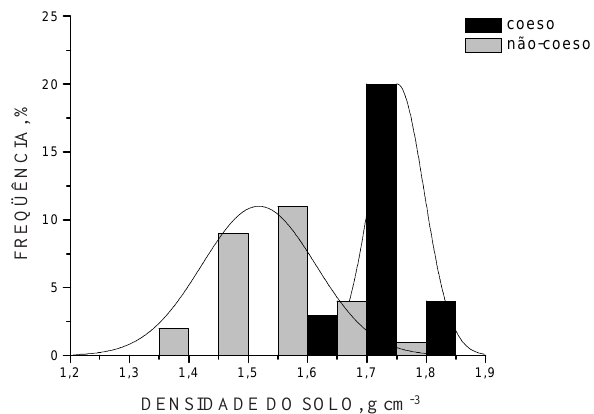
Figura 4. Freqüência de distribuição da Ds nos horizontes: coeso e